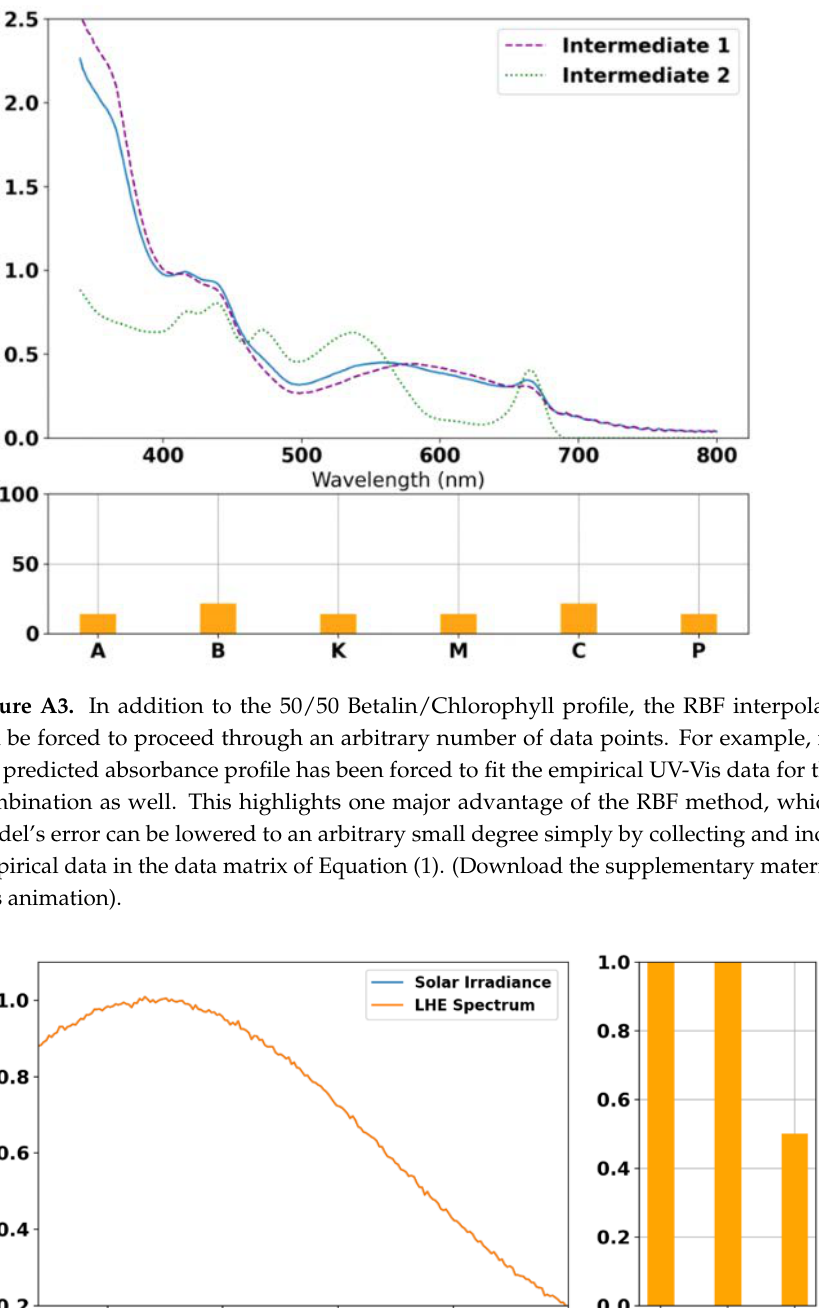
same 100% Betalin and 100% Chlorophyll profile starting points. Note: the purple curve represents the predicted absorbance for the rule of mixtures, not the RBF prediction. This purple curve is only intended to show how the RBF method succeeds where the rule of mixtures approach failed.